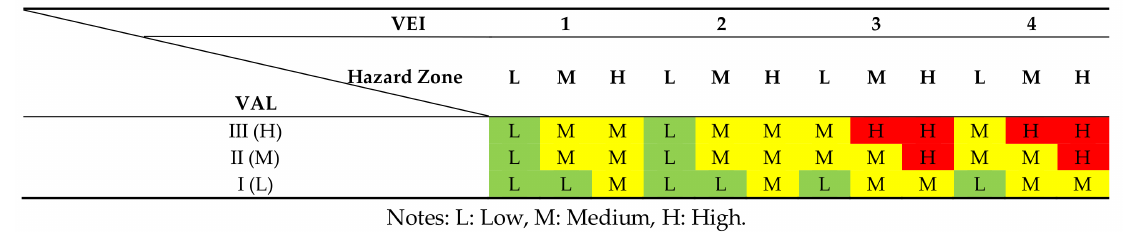
Table 4. Matrix relationship between the Volcanic Explosivity Index (VEI), VAL and the hazard level within hazard zones (adapted from